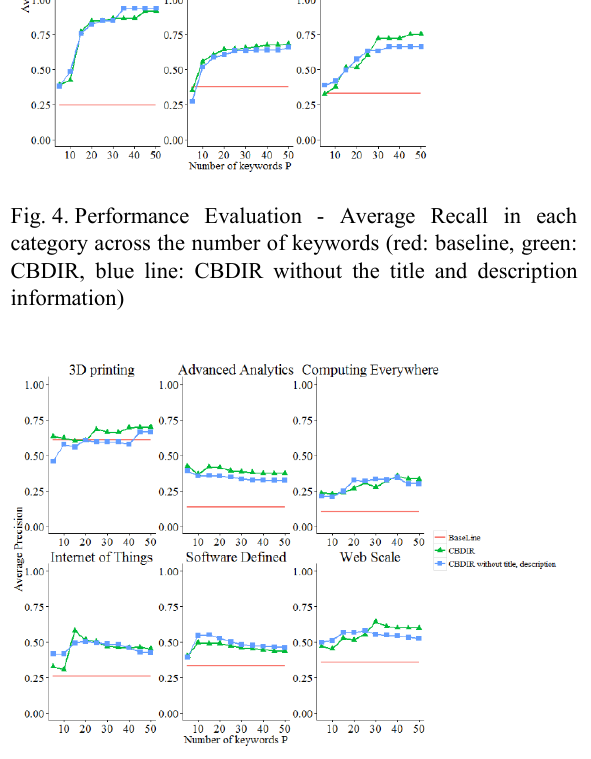
Fig. 5. Performance Evaluation - Average Precision in each category across the number of keywords (red: baseline, green: CBDIR, blue line: CBDIR without the title and description